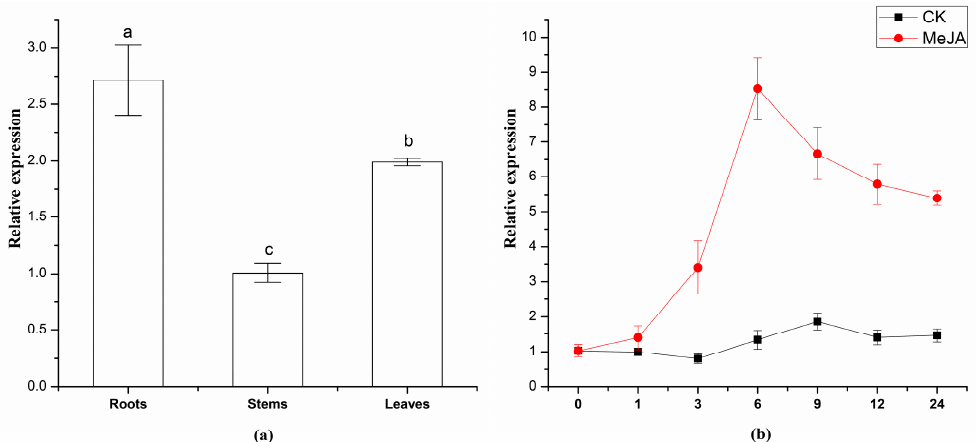
Figure 5. Expression analysis of TwSQS . ( a ) Expression analysis of TwSQS in different tissues of T. wilfordii ; ( b ) Expression levels of TwSQS in hairy roots after MeJA treatment. Data are means ± SEM ( n = 3). Letters on plots indicate significant difference according to Duncan’s multiple range test at p < 0.05. Me JA: methyl jasmonate-treated group; CK: untreated control